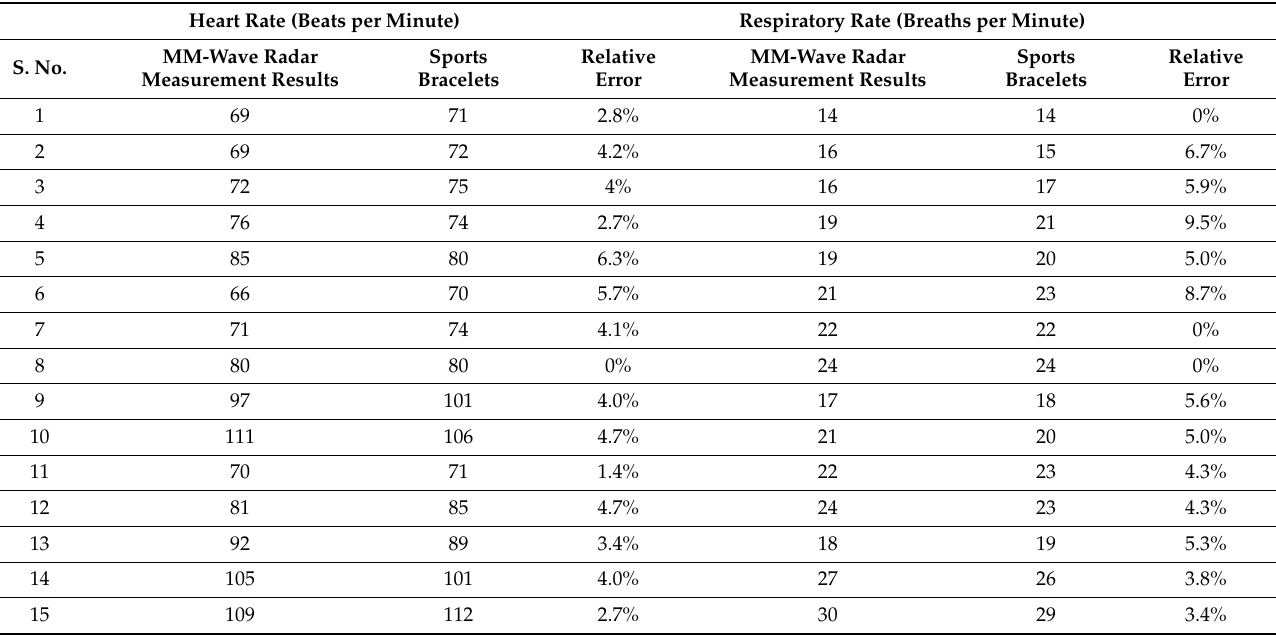
Table 2. The mm-wave radar detection vs. sports bracelet detection